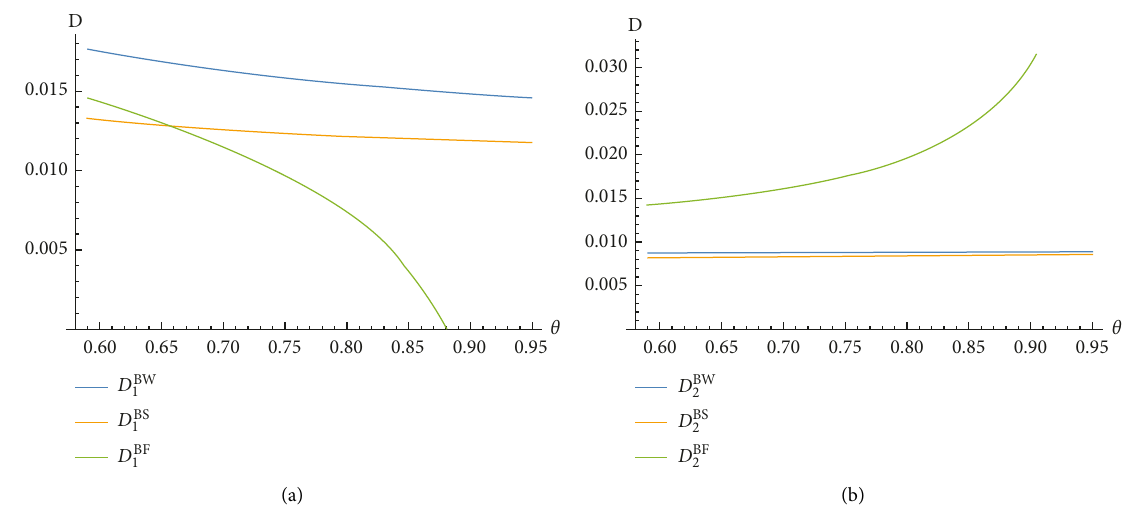
Figure 3: Demand comparison with respect to θ . (a) θ vs.D